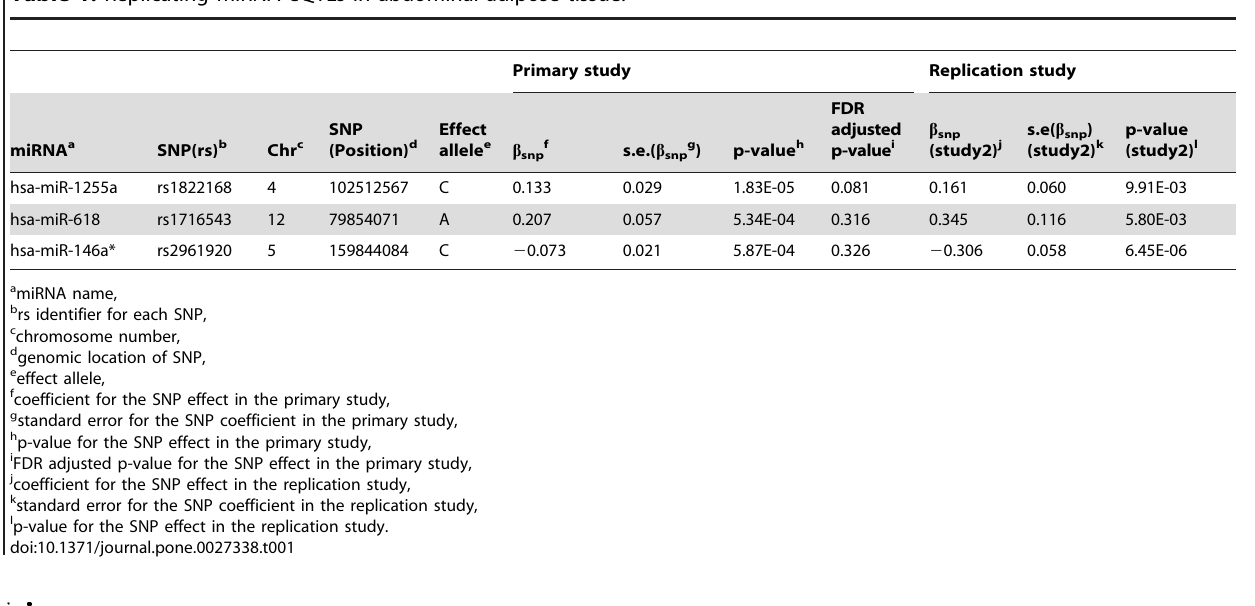
Table 1. Replicating miRNA eQTLs in abdominal adipose